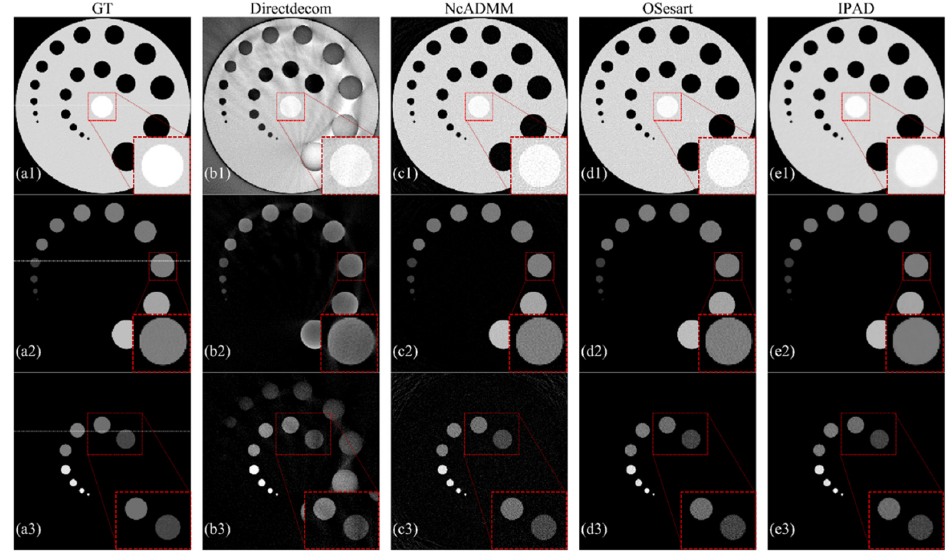
Figure 6. Results of the simulation dataset obtained by different methods with added noise (I 0 = 1 × 10 7 ). ( a1 )–( a3 ), ( b1 )–( b3 ), ( c1 )–( c3 ), ( d1 )–( d3 ), and ( e1 )–( e3 ) represent the tissue, bone, and iodine obtained by the GT, Directdecom, NcADMM, OSesart, and the proposed IPAD method, and their corresponding enlarged images, respectively. The display windows of the three materials are [0.01 1], [0.01 1], and [0.01 0.5], respectively.